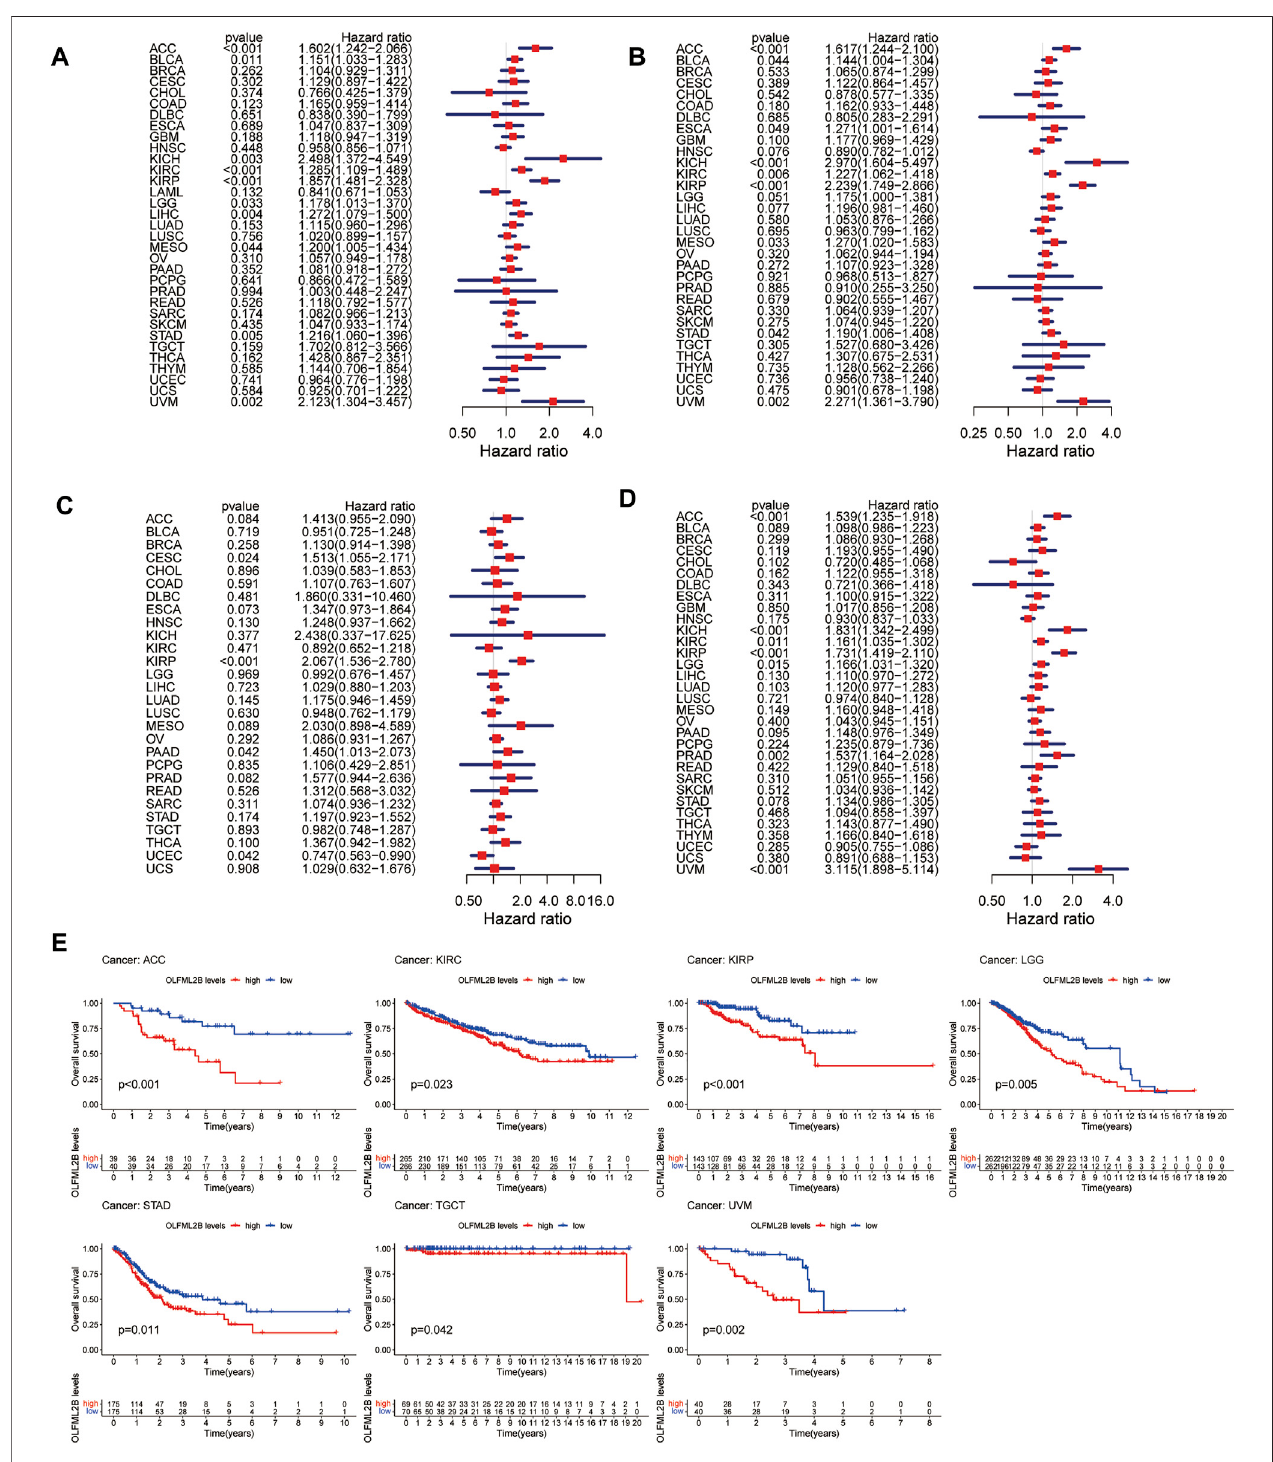
FIGURE 3 | Prognostic value of OLFML2B. (A) Forest plot of OS correlation in pan-cancer. (B) Forest plot of DSS correlation in pan-cancer. (C) Forest plot of DFI correlation in pan-cancer. (D) Forest plot of PFI correlation in pan-cancer. (E) KM analysis of the association of OLFML2B and OS.